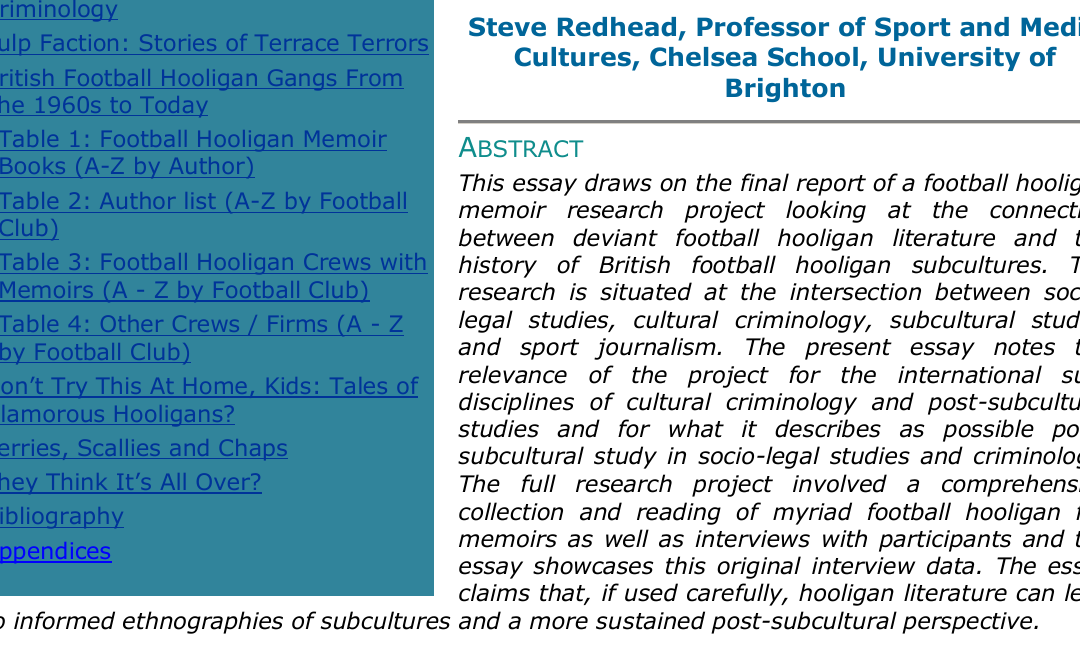
Table 1: Football Hooligan Memoir Table 2: Author list (A-Z by Football Club) Table 3: Football Hooligan Crews with Memoirs (A - Z by Football Club) Table 4: Other Crews / Firms (A - Z by Football